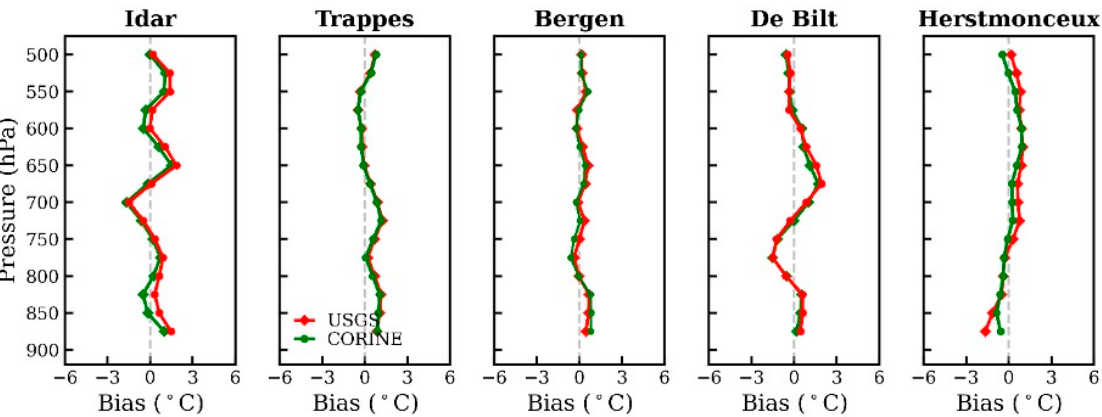
Figure 7. Vertical profile of bias in temperature over five radiosonde stations (Idar, Trappes, Bergen, De Bilt and Herstmonceux) on 18 August 2011 at 12 UTC. The values by WRF_USGS are presented in red colour, and the values by WRF_CLC are given in green colour.